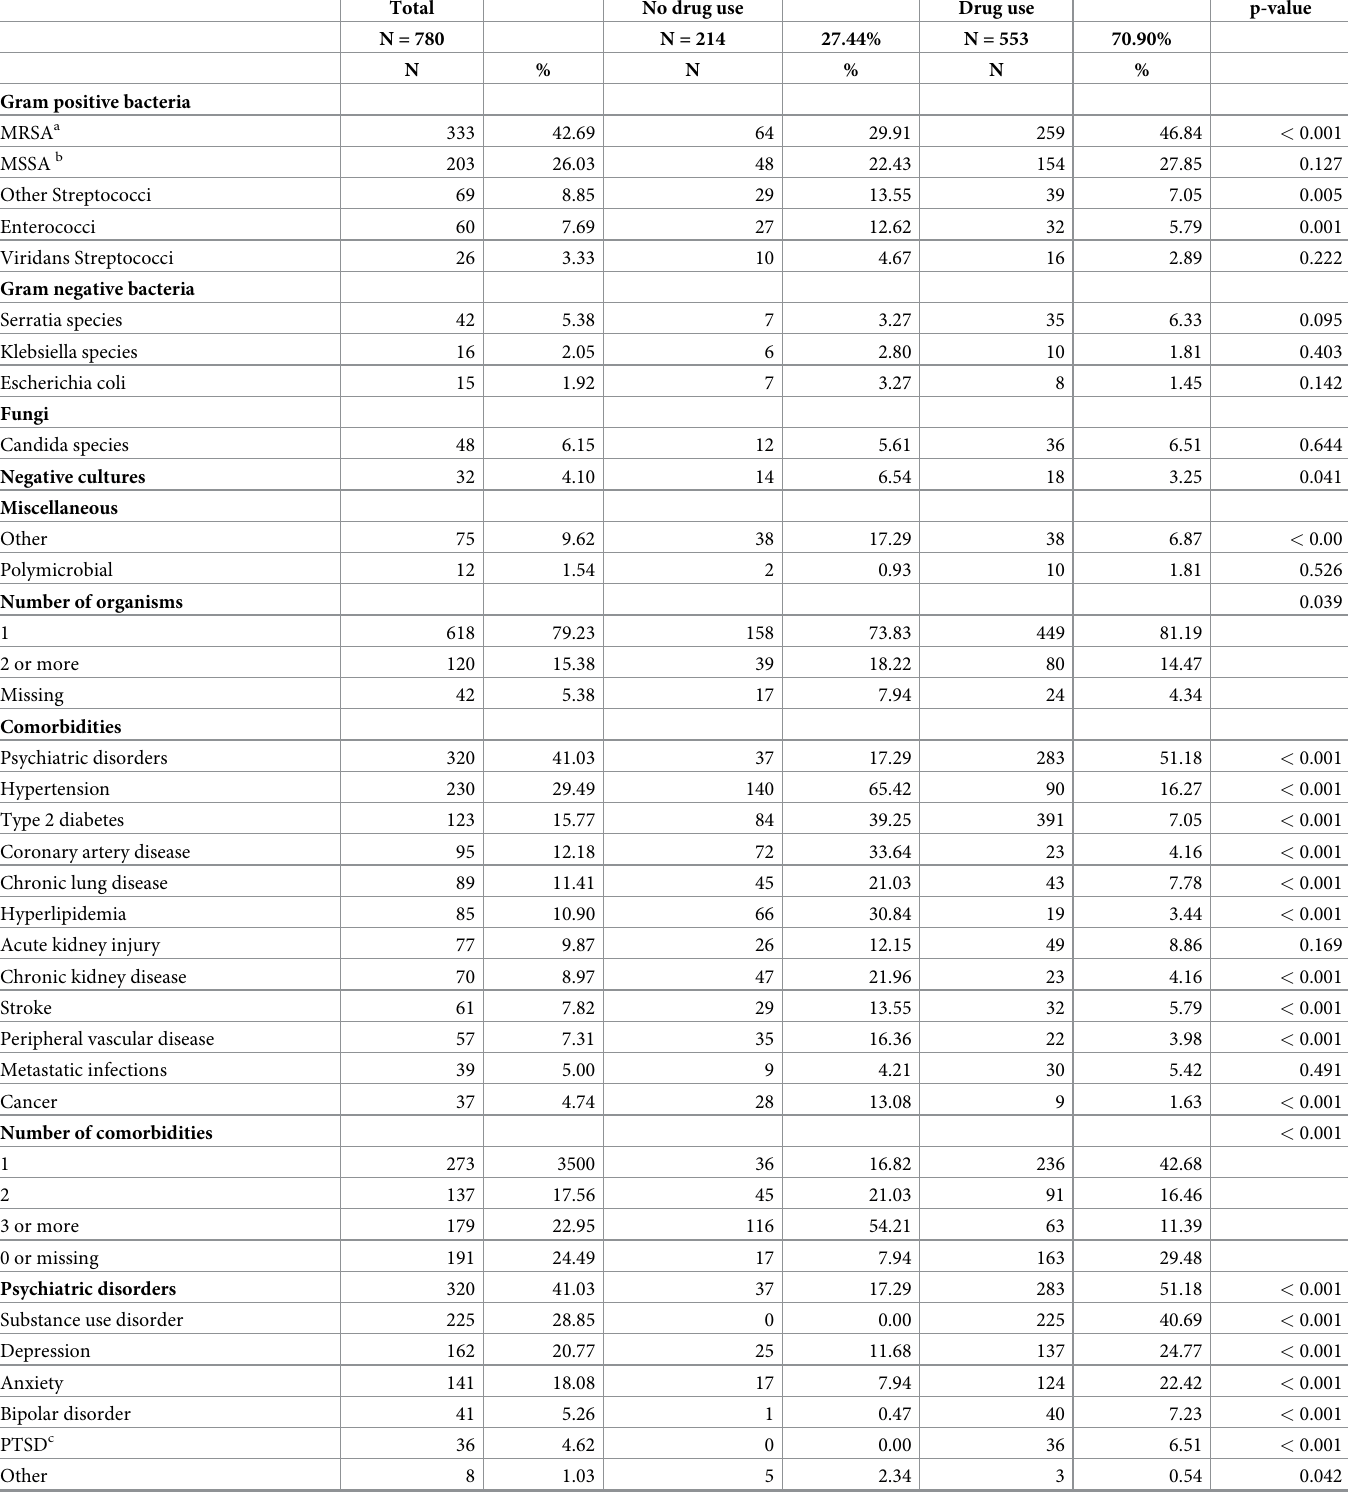
Table 2. Causative organisms and comorbidities among patients with infective